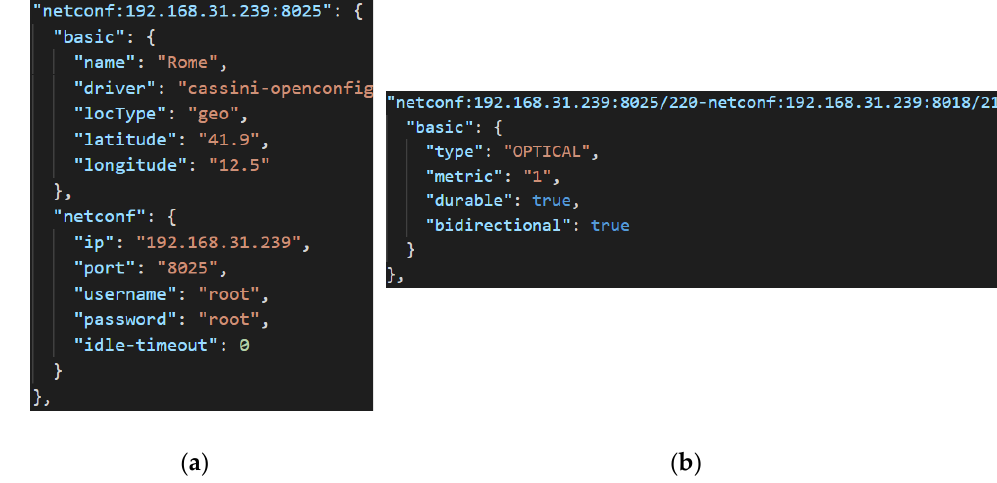
Figure 5. Topology details in the JSON configuration file: ( a ) Device definition; ( b ) Link definition.